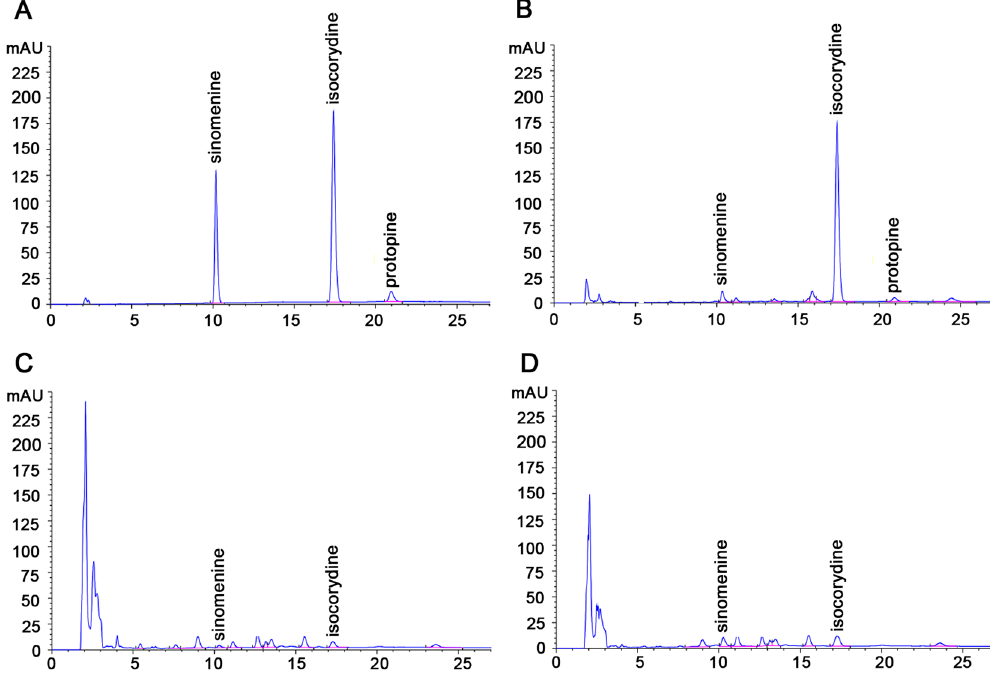
Figure 2. Chromatograms of three major IQAs in roots, leaves and stems of D . scandens . ( A ) HPLC chromatograms of sinomenine, isocorydine and protopine standards. HPLC chromatograms of sinomenine, isocorydine and protopine in D . scandens ( B ) roots, ( C ) leaves and ( D )